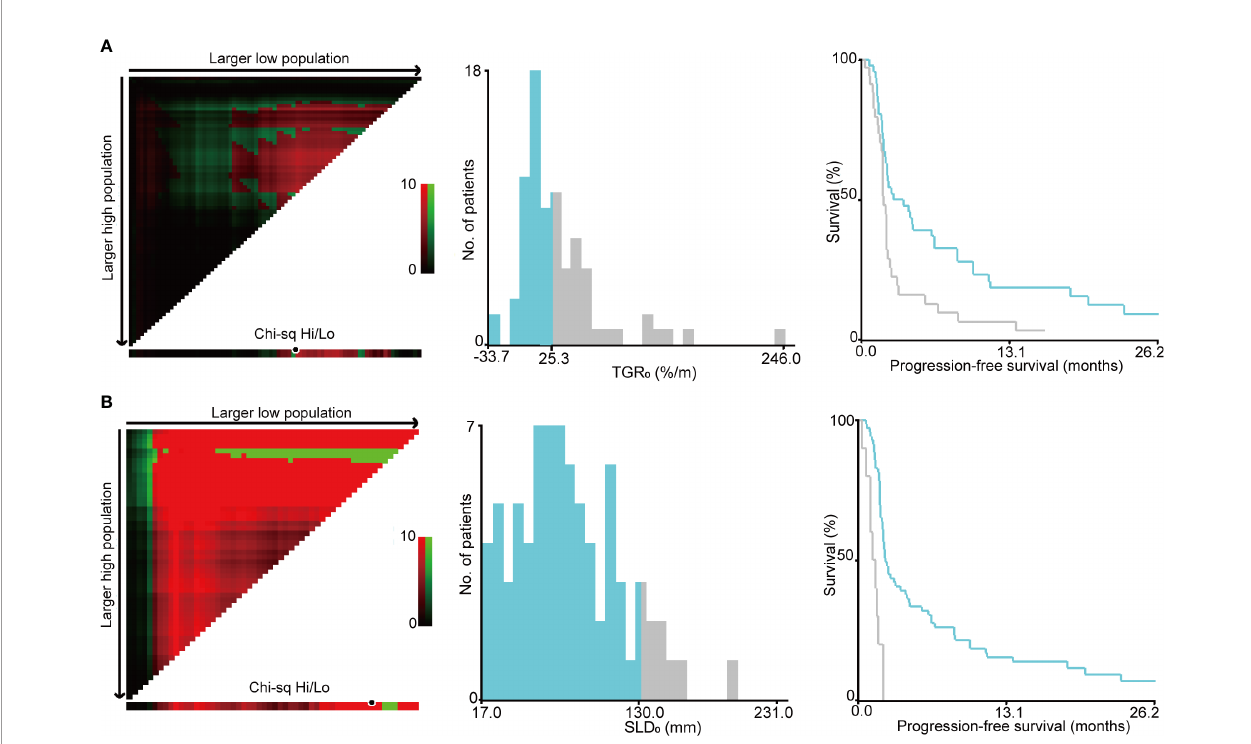
FIGURE 3 | Identi fi cation of cut-off values based on progression-free survival by X-tile analysis. (A) The optimal cut-off value for sum of the longest diameters of target lesions at baseline (SLD 0 ) was 130 mm ( c 2 = 22.995, P < 0.001). (B) The optimal cut-off value for pre-treatment tumor growth rate (TGR 0 ) based on PFS was 25.3%/m ( c 2 = 7.546, P =